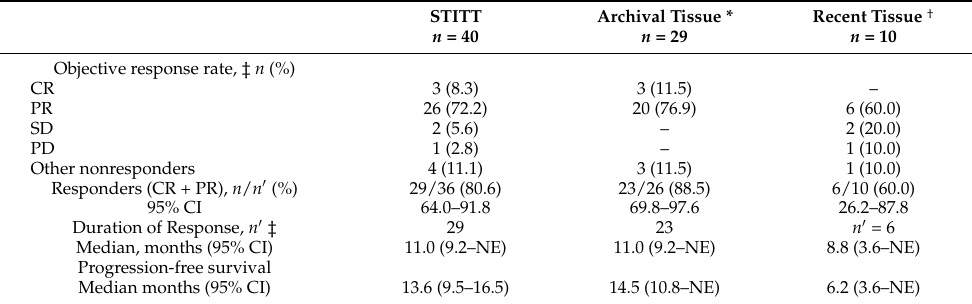
Table 3. Objective response rate and PFS